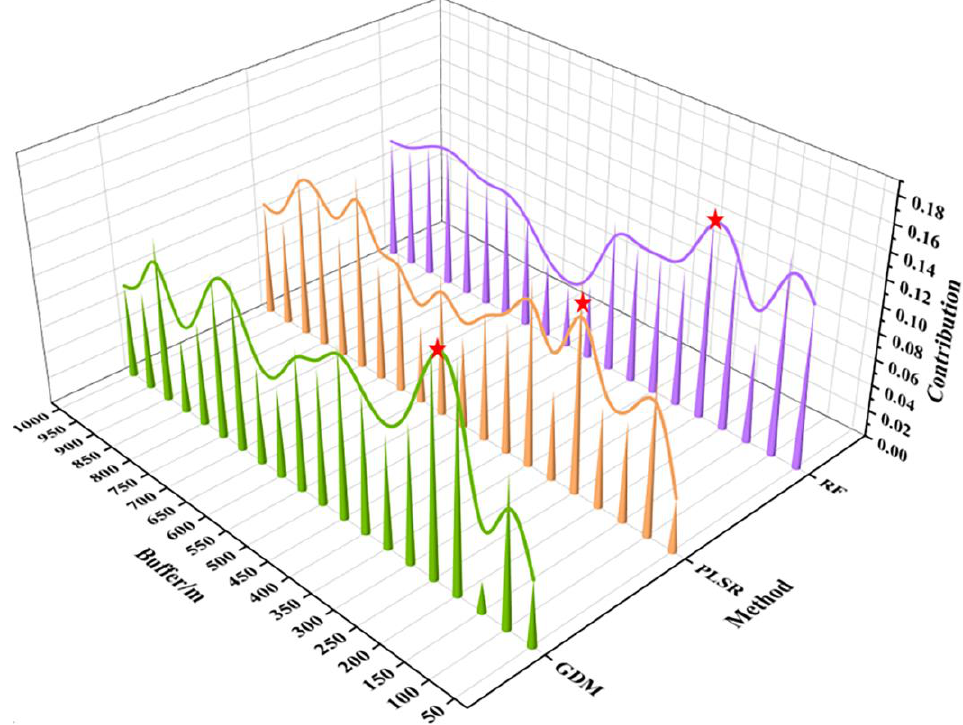
Figure 6. Contribution of GSC to BECCE in different buffers. The height of the green cone represents the contribution of GSC to BECCE in the different buffers obtained by GDM; the height of the